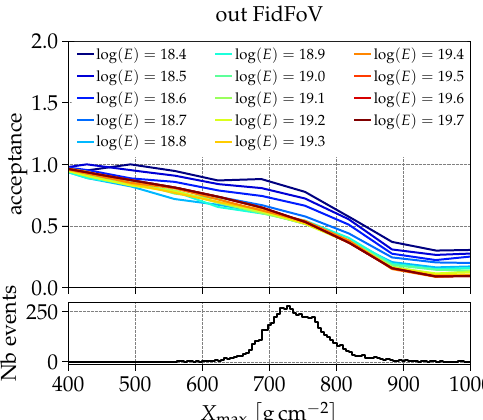
Figure 11: Top panel: acceptance for out- FidFoV data set split in 0.1 log ( E / eV) energy bins. The energy in the 10 legend is the lower energy edge of the bin, excepting 19.7 which corresponds to log( E / eV) 19 . 7. Lower panel: the  X max distribution of events for the full energy range.